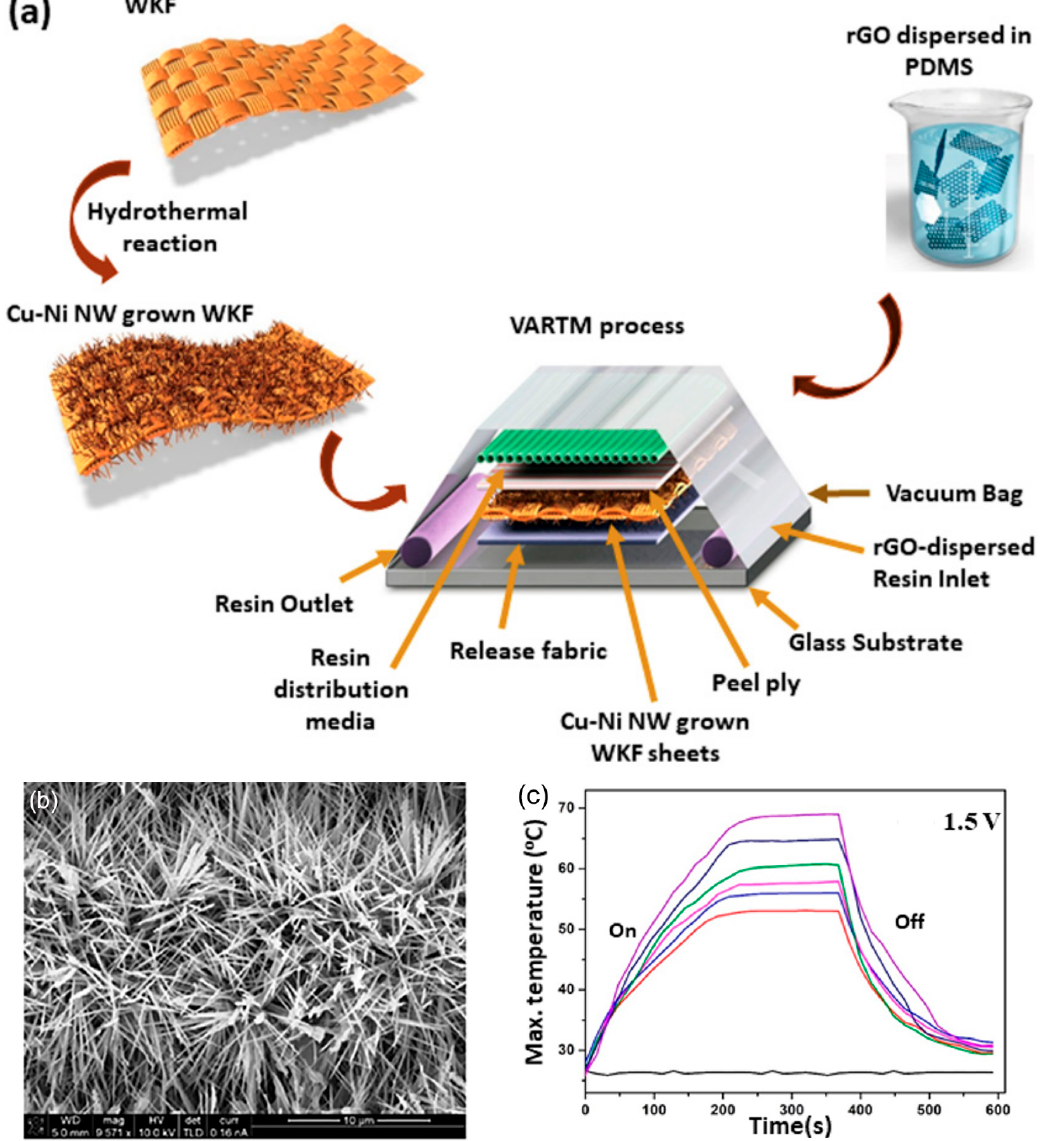
Figure 13. ( a ) Schematic diagram for preparation of the WKF/Cu − Ni/rGO/PDMS composite, ( b ) SEM image of Cu 3 Ni 1 NWs, and ( c ) time-dependent temperature profile during Joule heating of WKF composites. Reproduced from Ref. [121] with permission. Copyright 2018, American Chemical Society.